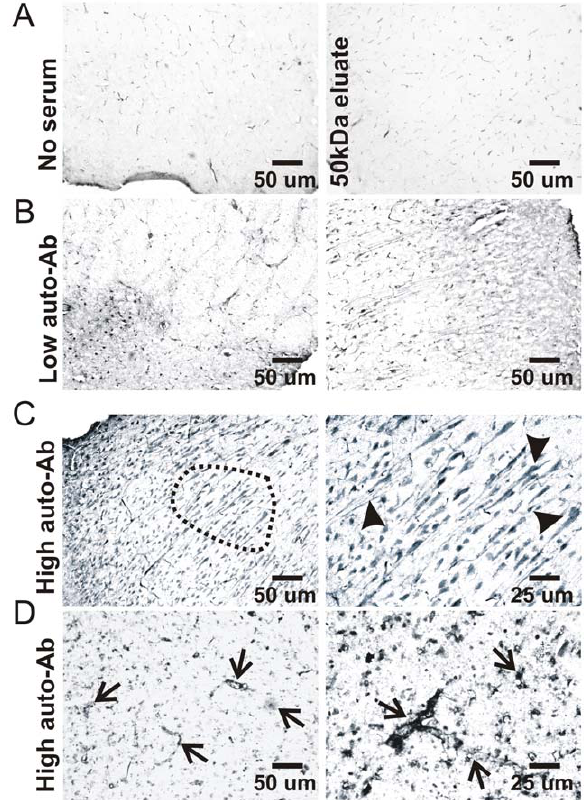
Figure 6. IgG from players with elevated anti-S100B levels recognize glial and neuronal epitopes. Serum samples obtained from selected players (highest and lowest auto-S100B antibody titers, see # and * in Figure 4) where used as ‘‘primary’’ antibody for recognition of brain epitopes. A control porcine brain was used (see text for details). A ) No signal was observed when serum was omitted or when brain slices were incubated with , 50 kDa serum fractions devoid of IgG. B ) Low levels of brain immune reactivity was observed when using the serum sample from the player with lowest auto-S100B antibody levels. C–D ) A more pronounced signal was observed when using the serum from the most ‘‘auto-immune’’ sample. Both glial and neuronal staining were stained by these IgGs, supporting the hypothesis that auto-immunity is not limited to the glial protein S100B but rather extends to other neuronal